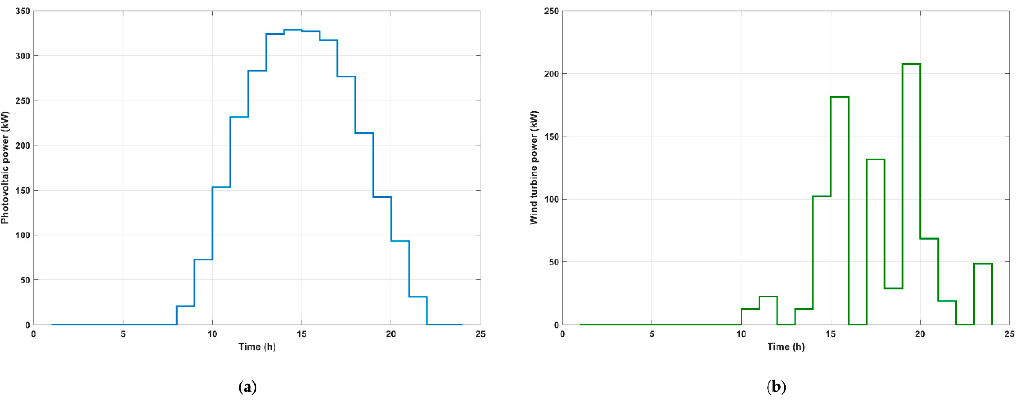
Figure 5. Power output of ( a ) photovoltaic solar panels and ( b ) wind turbines in the renewable microgrid–plug-in electric vehicles parking lot (RMG-PEVs) system.